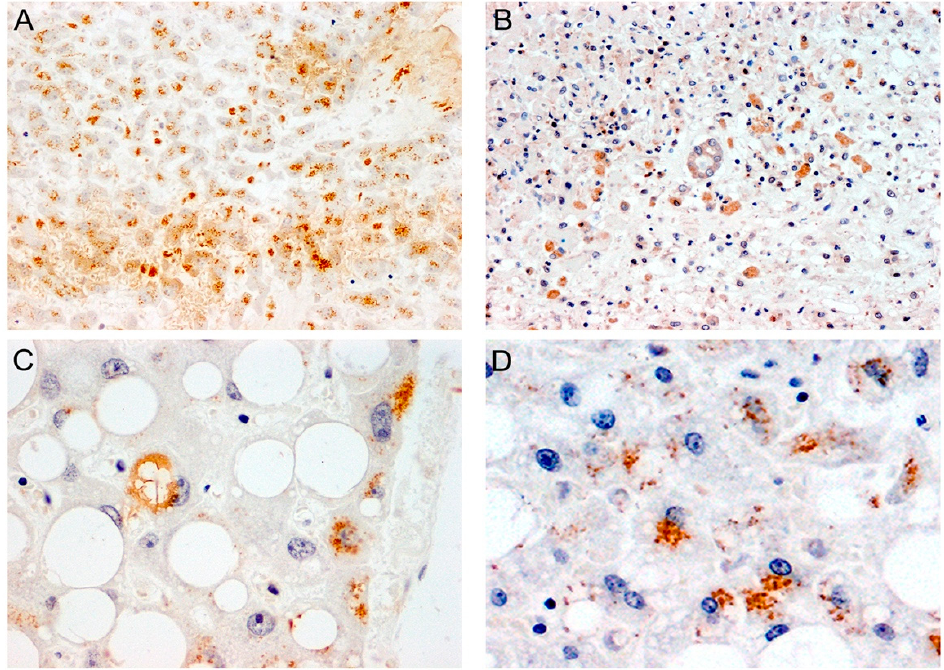
Figure 3. Detection of SARS-CoV-2 proteins in liver samples. Immunohistochemistry for SARS- CoV-2 Nucleocapsid shows robust immunoreactivity in hepatocytes, in areas of liver damage (Panel ( A ) original magnification 100× and Panel ( C ) original magnification 400×). Spike protein is also present in the cytoplasm of hepatocytes in areas of necrosis (Panel ( B ) original magnification 100×, and steatosis (Panel ( D ) original magnification 400×).